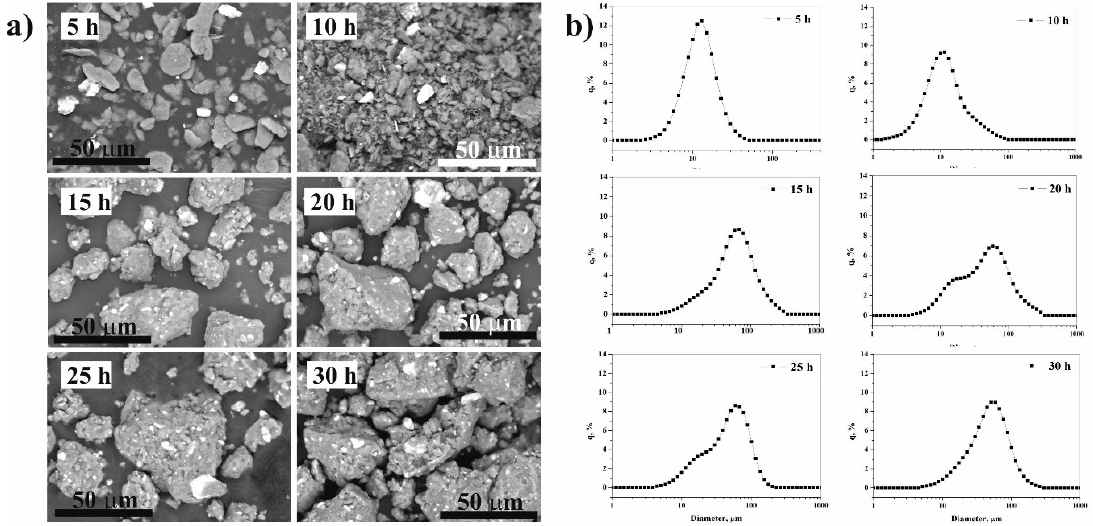
Figure 2. Scanning electron microscopic (SEM) images ( a ), XRD pattern ( b ), DSC thermogram ( c ), and particle size distribution ( d ) of the Cu 36 Zr 48 Ag8Al 8 powder.